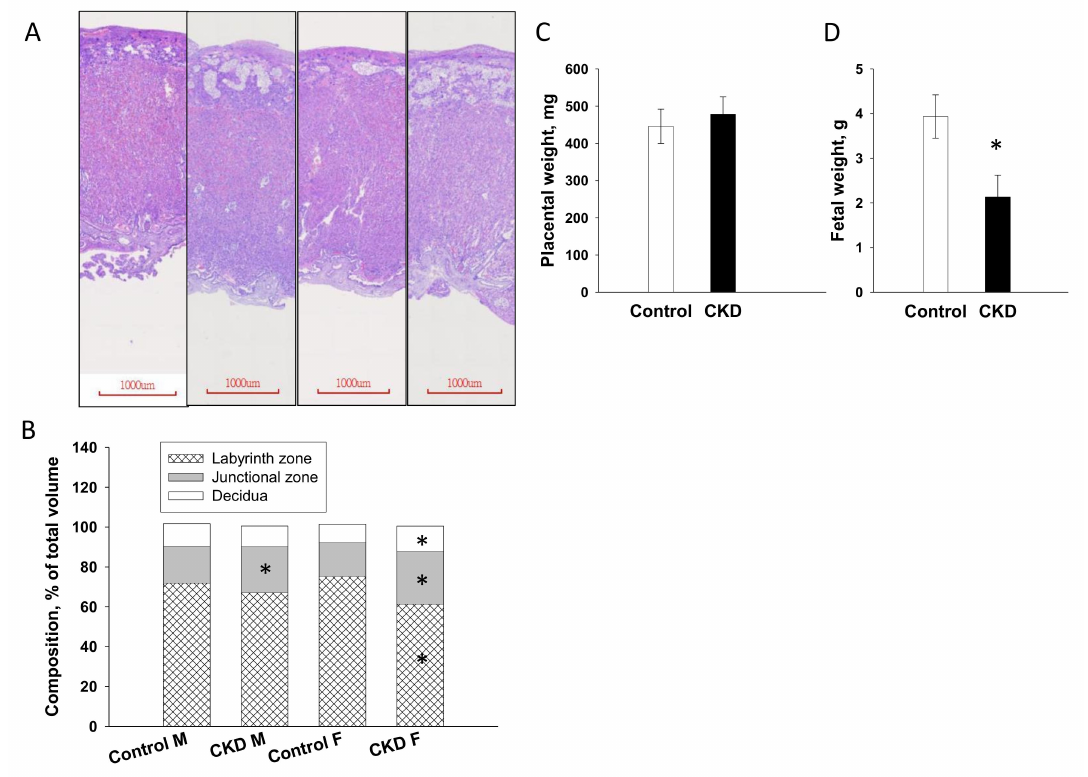
Figure 2. Placenta and fetal weight. ( A ) Hematoxylin and eosin stained sections demonstrating histological appearance of the placental layers of pregnant rats fed with regular chow (control) or chow supplemented with 0.5% adenine (CKD) at gestational day 21; scale bar = 1000 µ m, ( B ) mean percentage of total volume of the decidua, junctional zone, and labyrinth zone; M = male fetus; F = female fetus, ( C ) placental weight, and ( D ) fetal weight. Data are shown as means ± SD; n = 5 / group. The asterisk indicates p < 0.05 vs.